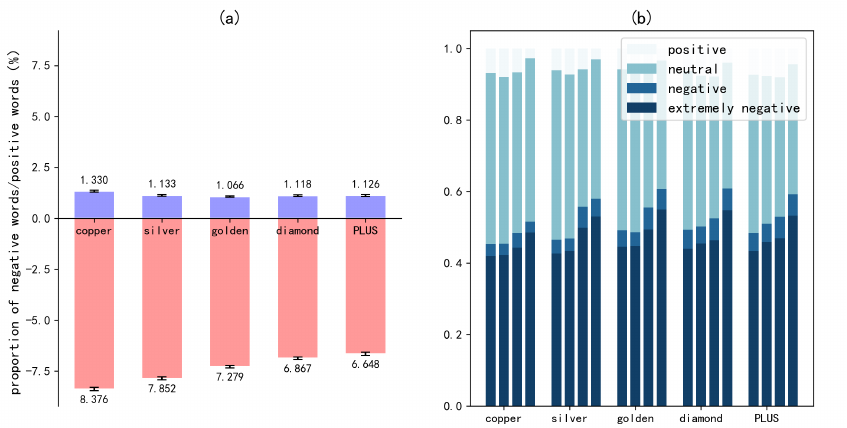
Figure 10. ( a ) Average proportions of positive and negative emotion words in negative reviews of 2017 . ( b ) Distribution of user emotion from different user levels in the four sectors . ( a ) The bars on the upper side of the x -axis represent the percentage of positive emotion words from five user levels, while those on the underside indicate that of negative ones. The absolute value of the y -axis means the percentage of emotional words. The error bar is calculated by the sample standard deviation. ( b ) A stacked histogram for emotion distribution of user levels. Bars of different colors represent the percentage of different degrees of emotion, which is divided into positive, neutral, negative and extremely negative according to i polar . The x -axis refers to the five user levels, and the four bars on a certain user level are for the sectors of Gifts and Flowers, Clothing, Computers and Phone and